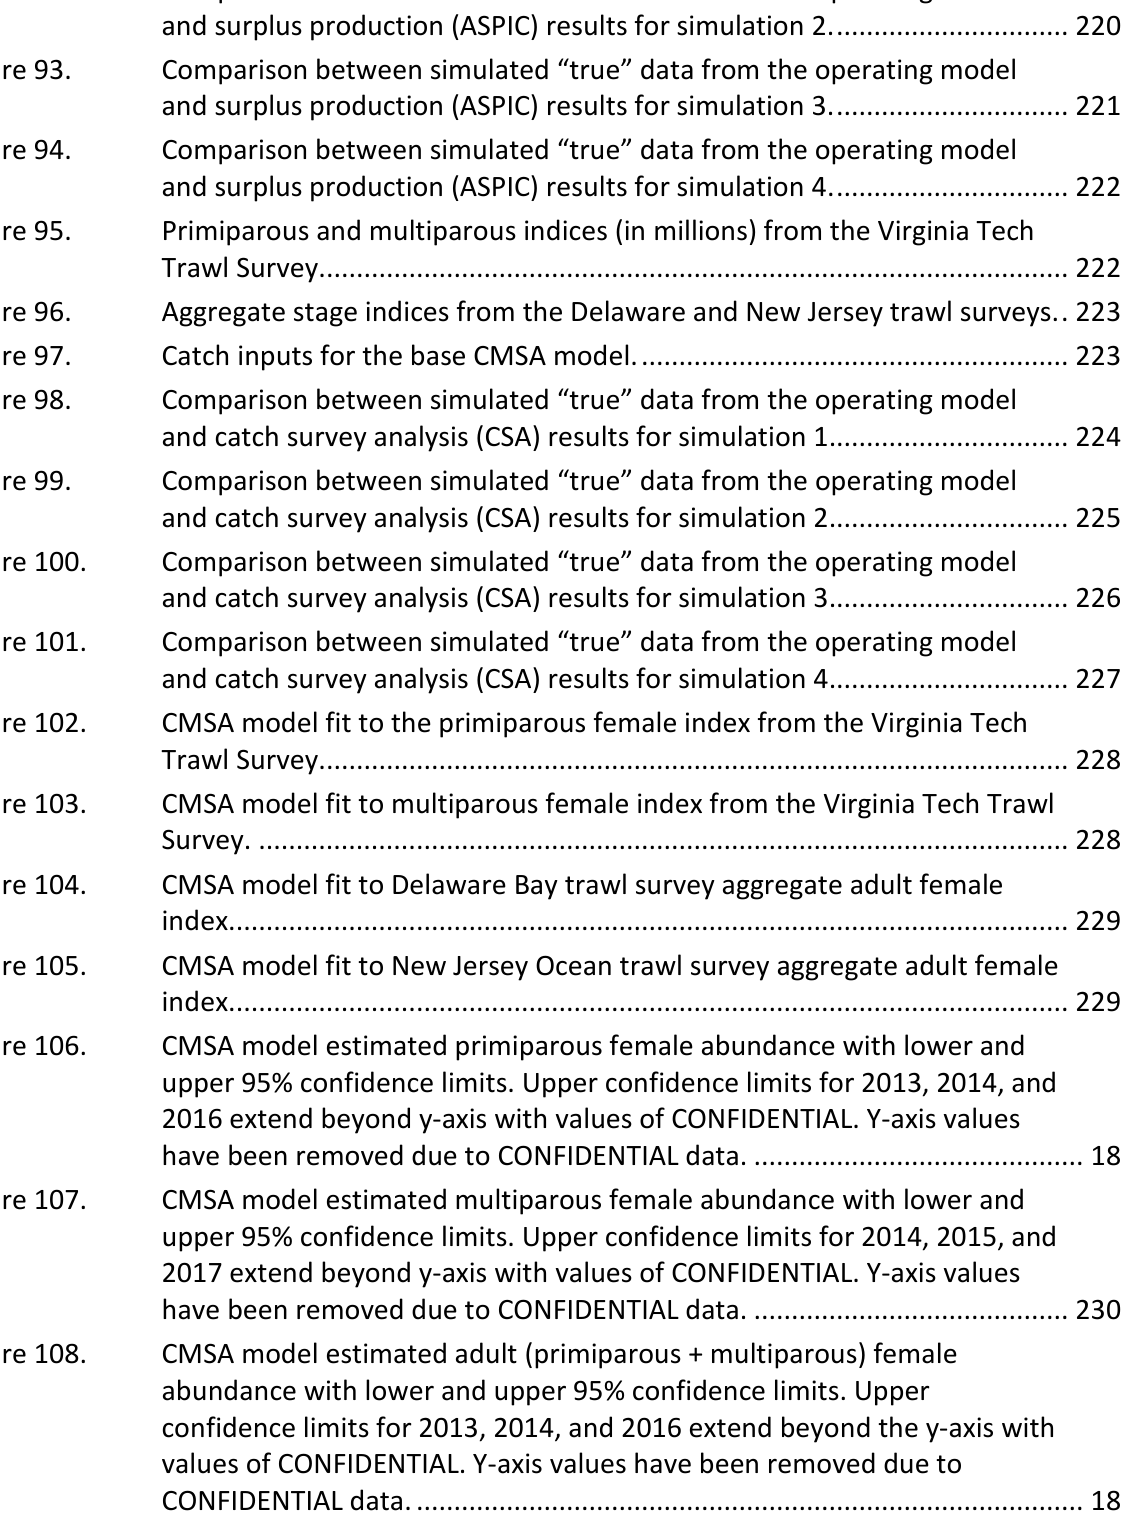
2019 Horseshoe Crab Benchmark Stock Assessment Non-Confidential Report